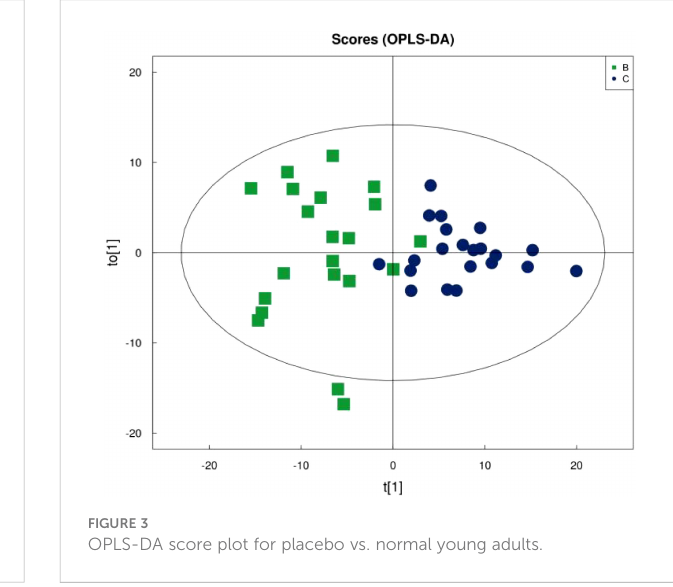
FIGURE 1 OPLS-DA score plot of treatment group versus normal control group.